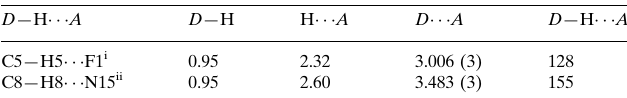
Hydrogen-bond geometry (A˚ , (cid:1)